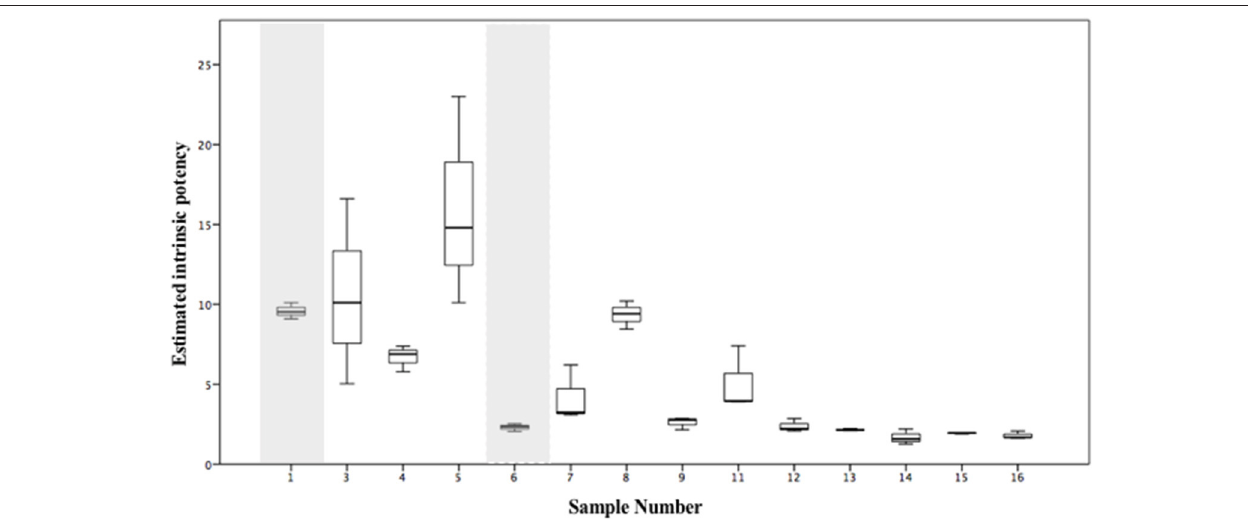
FIGURE 7 | Estimated intrinsic potency values, calculated using equation 1 and/or equation 2, from replicate analyses ( n = 3) of alleged “spice” samples seized in Manchester, UK. Shaded areas identify samples for which estimated intrinsic potency values have been calculated. Intrinsic potency values for sample 2 (see Table 3 ) have not been calculated due to insufficient sample for quantitative analysis. Sample 10 (see Table 3 ), in which both AMB-FUBINACA and EMB-FUBINACA were detected has also been omitted as no comparative data for potency (EC 50 ) is currently available for